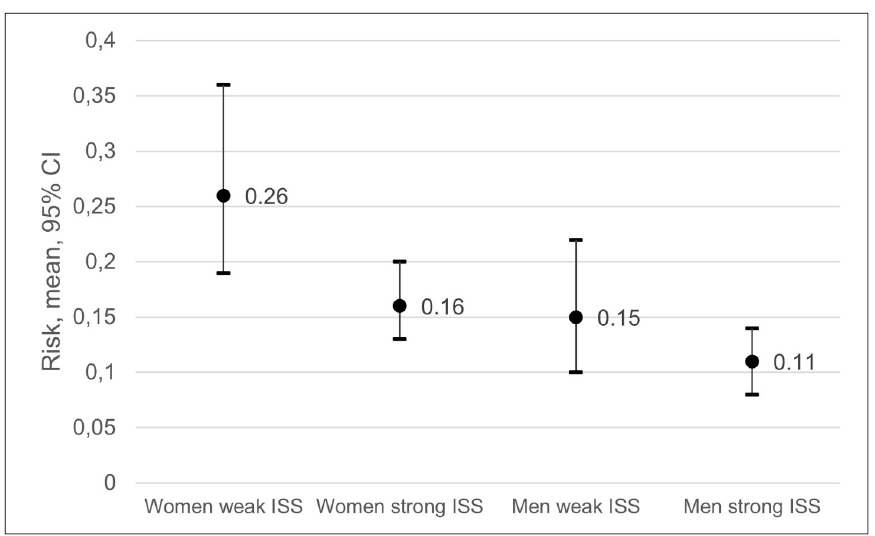
Fig 3. Risk of frequent pain at follow-up among women with weak instrumental social support (ISS), women with strong ISS, men with weak ISS and men with strong ISS at baseline.